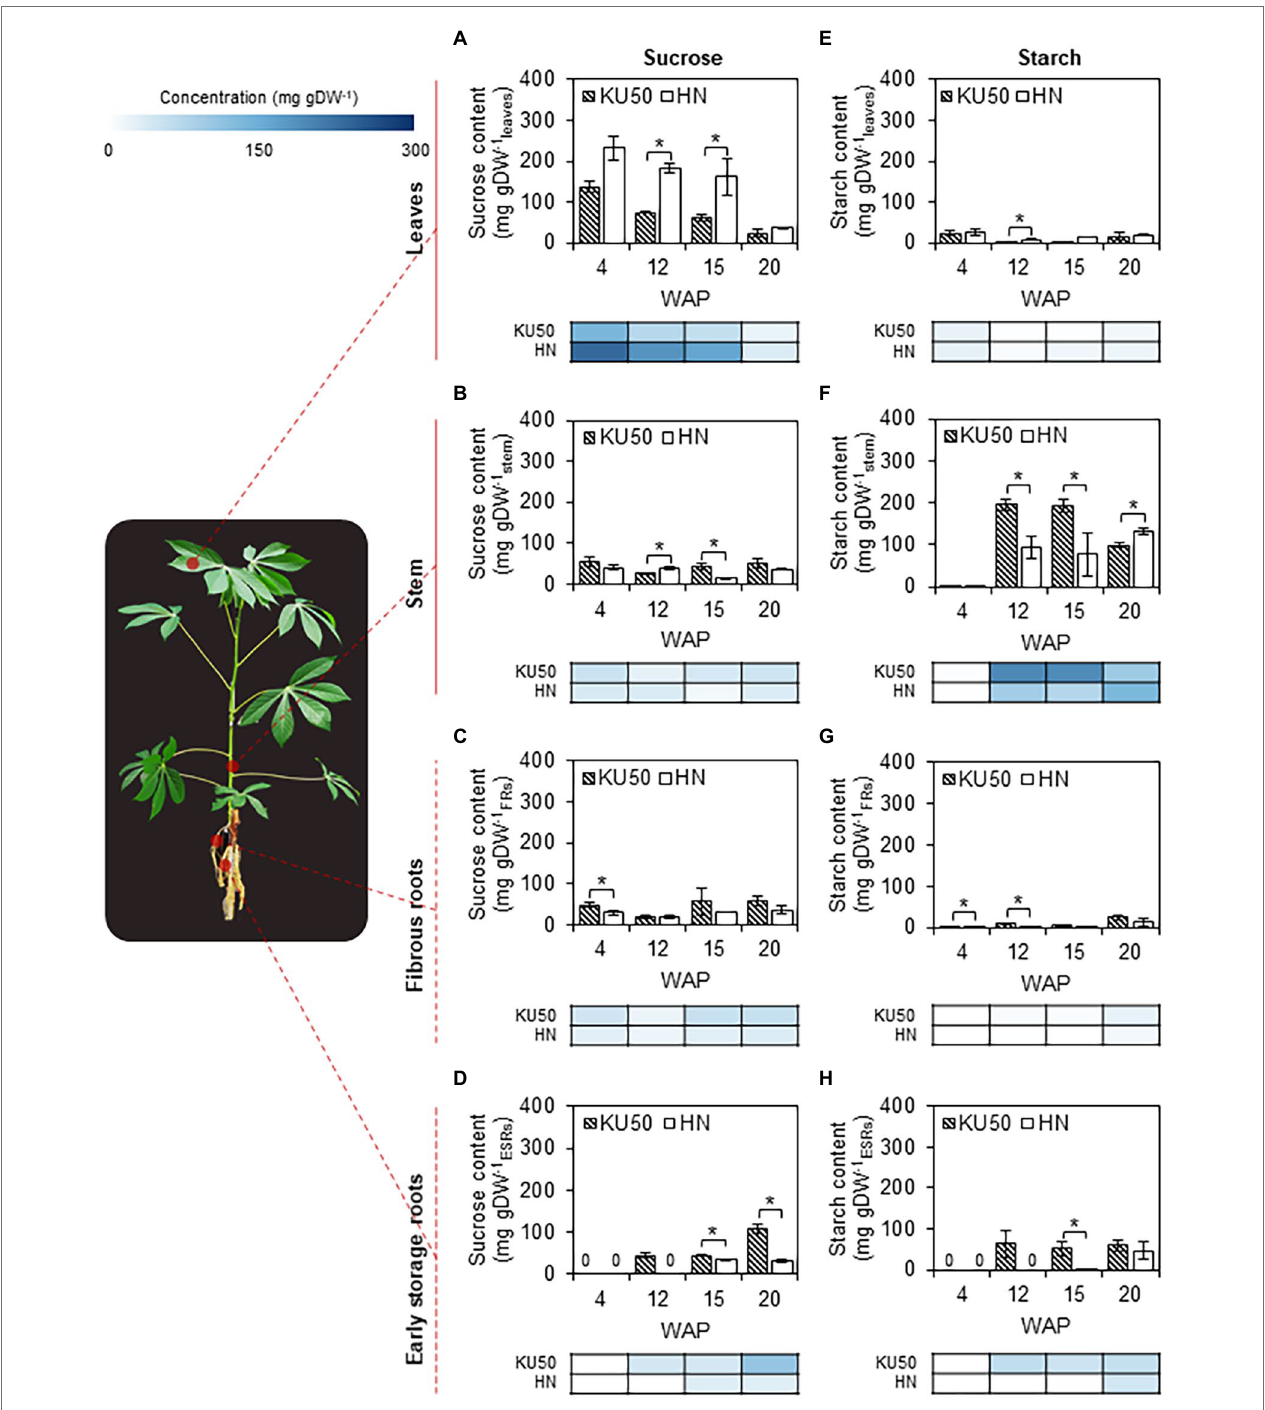
FIGURE 2 | Changes in sucrose and starch contents in (A,E) leaves, (B,F) stems, (C,G) fibrous roots (FRs), and (D,H) early storage roots (ESRs) at various developmental stages of Kasetsart 50 (KU50) and Hanatee (HN) cassava varieties grown under greenhouse conditions, determined at midday on a dry weight basis. The heat map located under each figure clearly displays the proportion of each tissue on a dry weight basis at various developmental stages. Each result is the mean ± SE of values obtained from three biological replicates. Statistical significance, based on a one-sided Student’s t -test, is denoted by * p ≤ 0.05. gDW, gram dry weight and WAP, week after